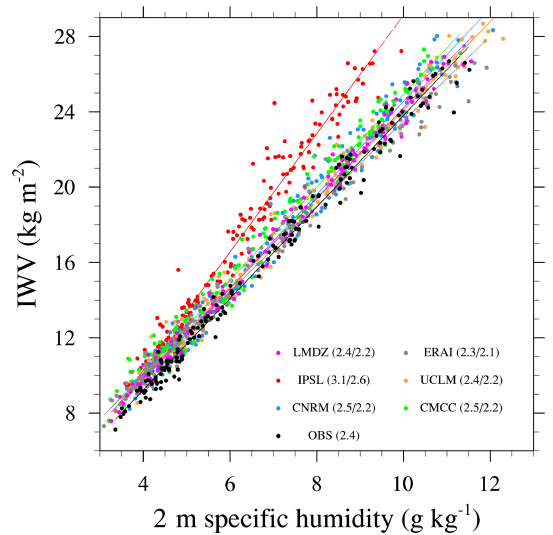
Figure 4. Monthly values of IWV as a function of monthly val- ues of 2m specific humidity (Q2) averaged over all stations where and when both IWV from GPS and Q2 from HadISD are available. Monthly means are computed if at least 60 coexisting values ex- ist (i.e., about two values per day over a possible four). A total of 3238 months are obtained, spread over 42 different stations. The average number of stations per month is 19 with a maximum of 30 stations). The color of circles corresponding to each model is indi- cated on the legend. All model outputs have been regridded to the ERAI grid. The first number indicates the slope of the regression obtained when considering the same months than observations at each station, while the second number is the slope of the regression when considering all months at all grid points (only models).